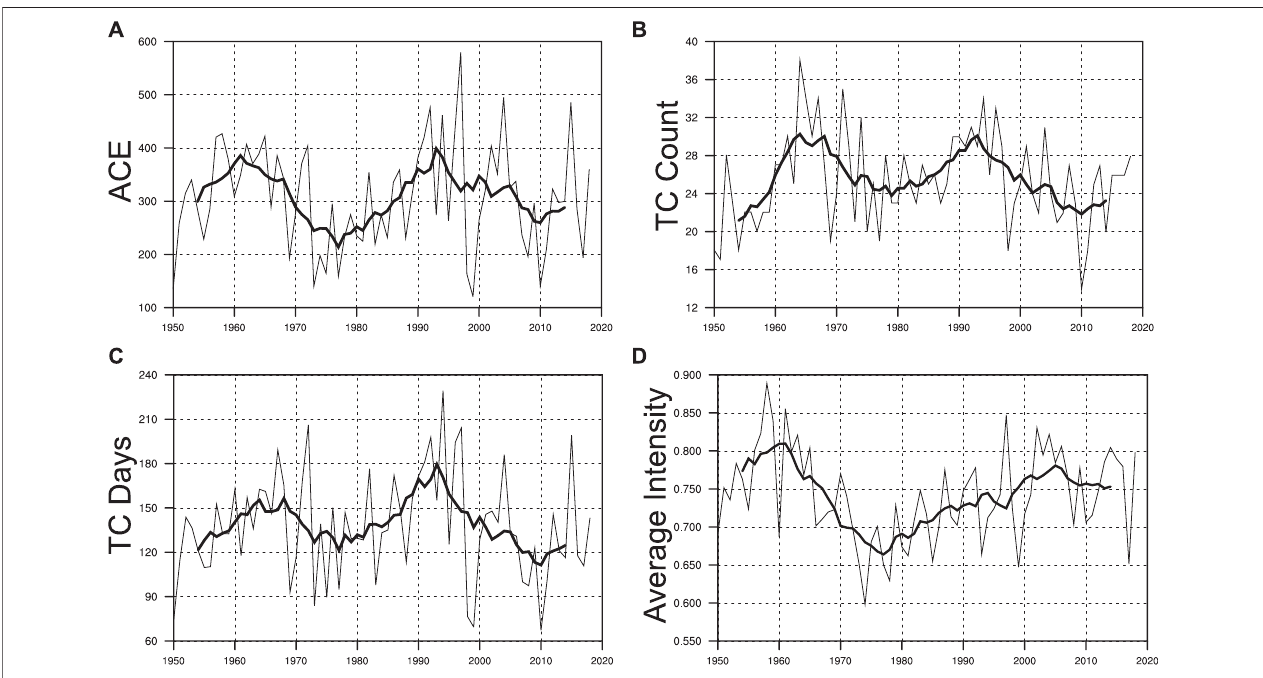
FIGURE 1 | Interannual-to-decadal variability of various TC metrics. Time series of annual mean (A) ACE index (unit: 10 4 · knot 2 ), (B) frequency, (C) TC days (unit: days) and (D) average intensity (unit: 10 2 · knot ) of TCs in the western North Paci fi c as a function of time for 1950 – 2018 (thin solid black curve). The thick black curve in each panel shows the 9-year running averages. The long-term linear trends were removed.